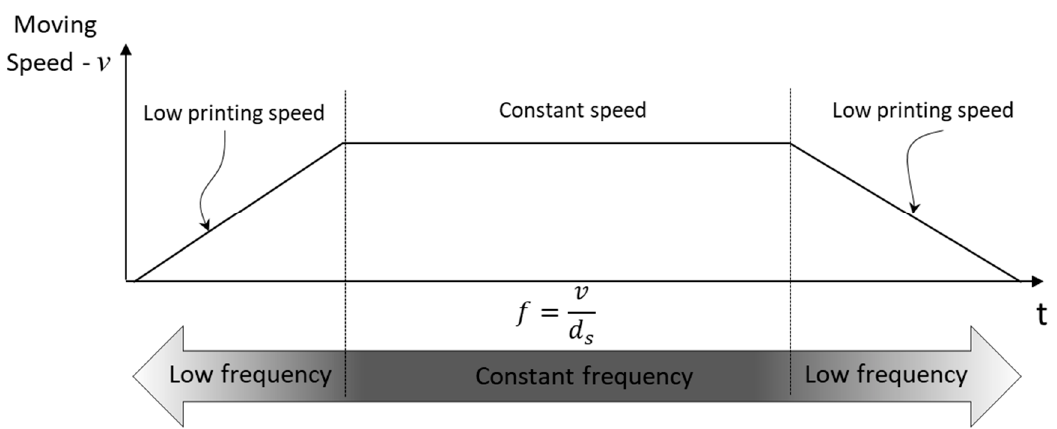
Figure 7. Jetting frequency effects using the EPU according to printing speed.